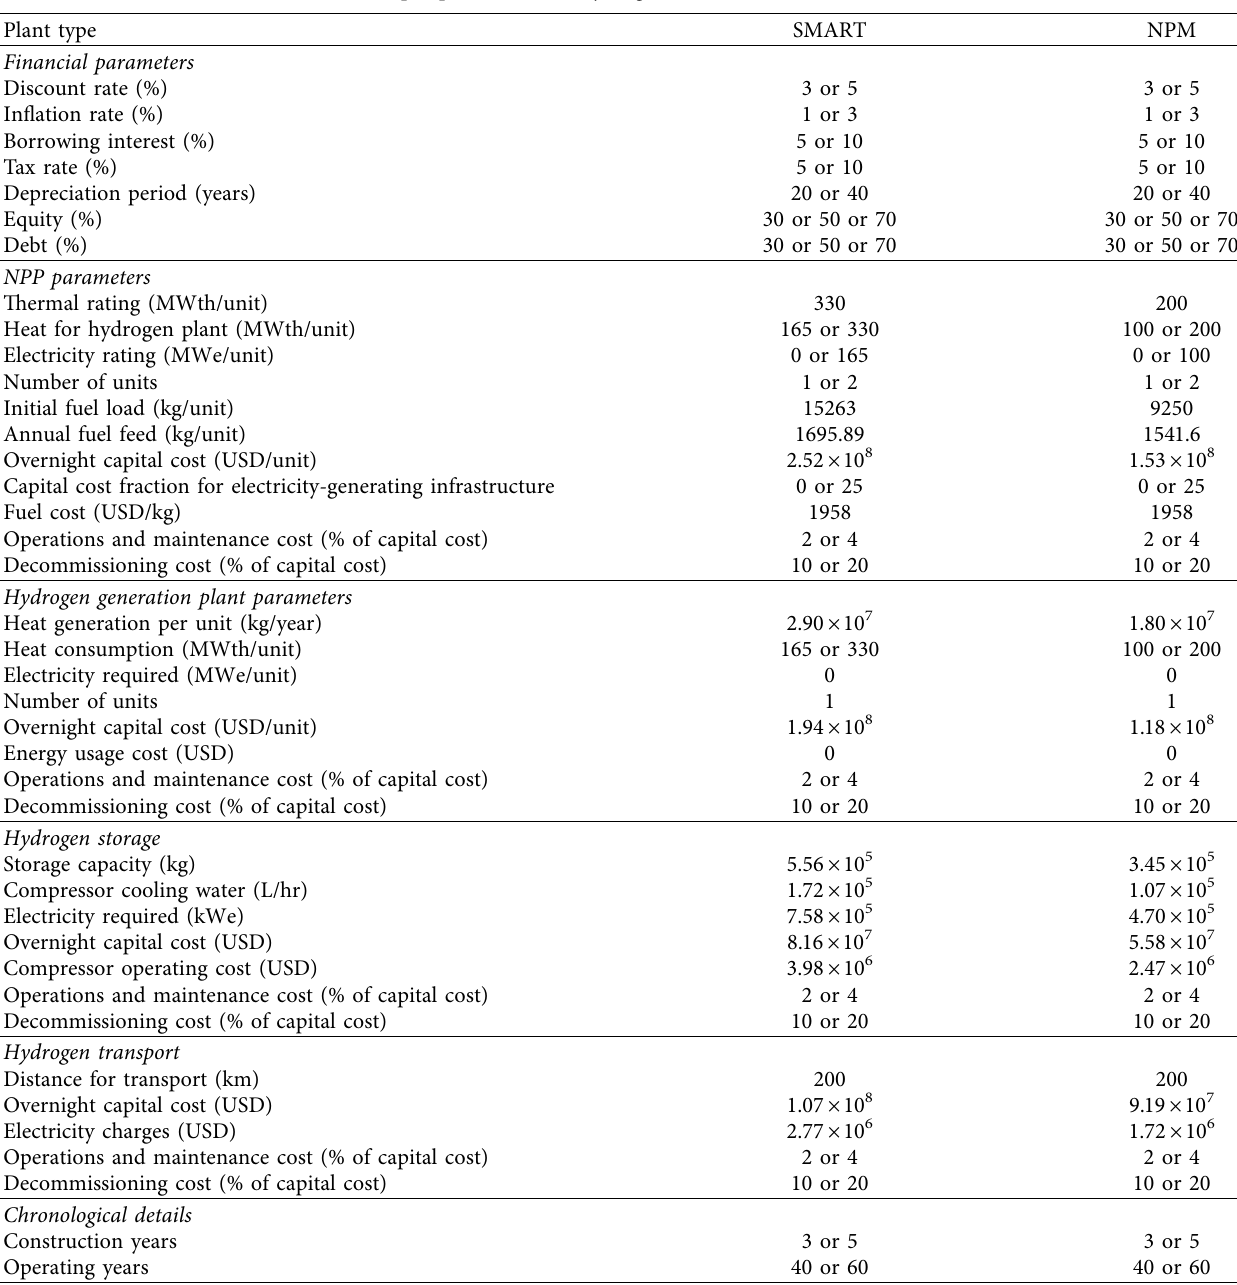
Table 2: Input parameters for hydrogen economic evaluation [22,